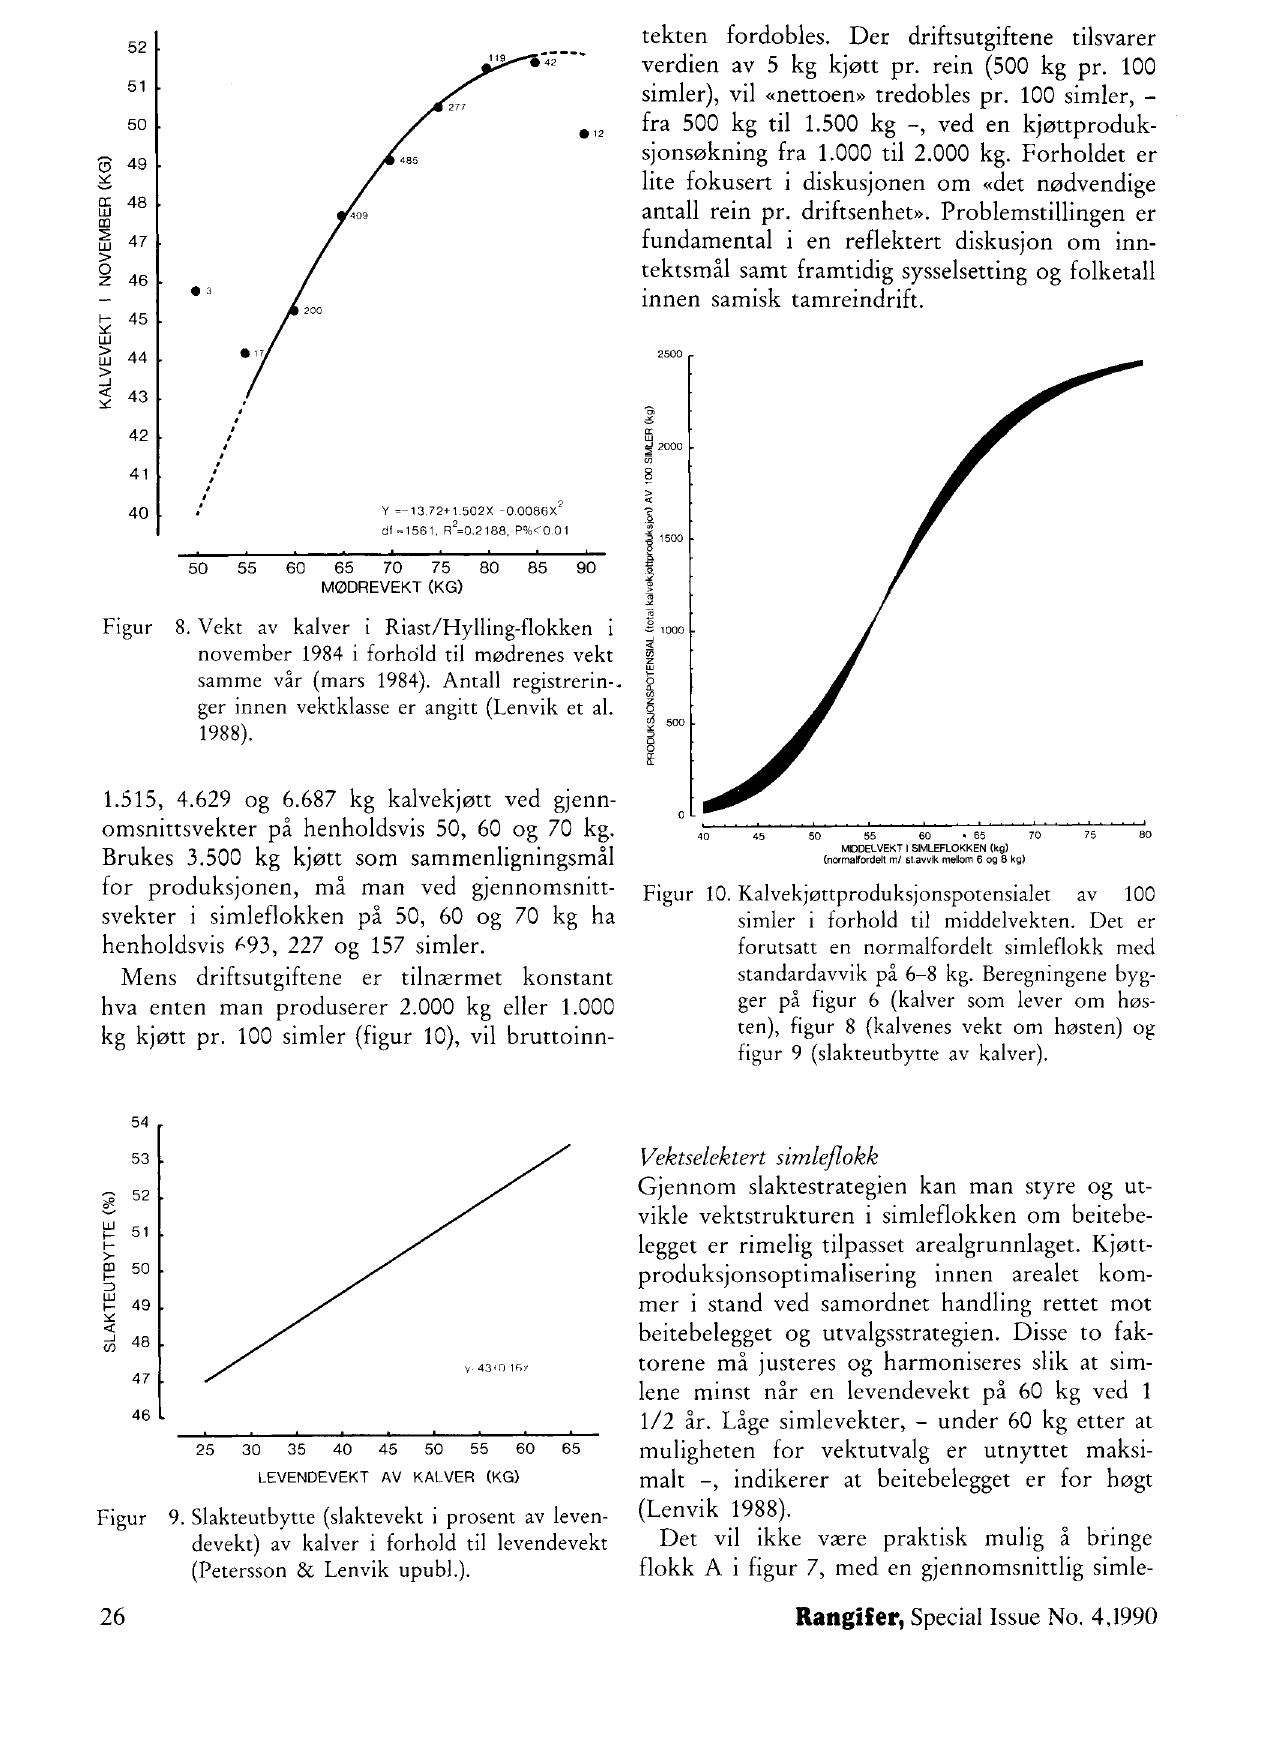
Figur 9. Slakteutbytte (slaktevekt i prosent av leven- devekt) av kalver i forhold til levendevekt (Petersson & Lenvik